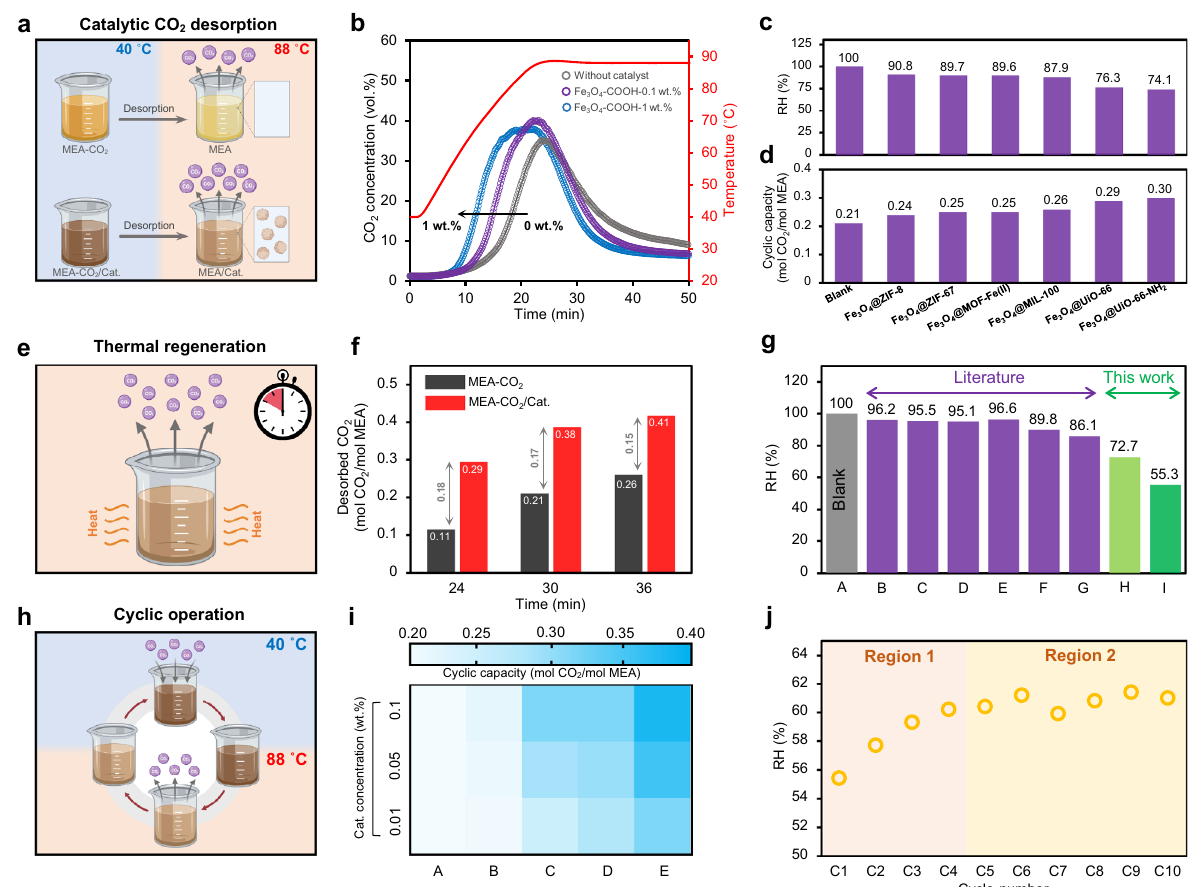
Fig. 5 Application of water-dispersible nanocatalysts for energy-ef fi cient CO 2 capture. a Schematic of amine solvent regeneration with and without using a catalyst (Cat.). b CO 2 desorption pro fi le of amine solution with different concentrations of Fe 3 O 4 – COOH. c Relative heat duty (RH) and d cyclic CO 2 uptake capacity of amine solution in the presence of various water-dispersible core – shell nanomaterials. e Schematic of catalytic CO 2 desorption during thermal solvent regeneration. f The effect of time on the accumulative desorbed CO 2 with and without using Fe 3 O 4 @UiO-66 – SO 4 . g RH of amine solution without ( a ) and with heterogeneous catalysts (Al 2 O 3 ( b ), V 2 O 5 ( c ), H-Beta ( d ), HZSM-5 ( e ), SO 4 2 − /ZrO 2 /Al 2 O 3 ( f ), SO 4 2 − /ZrO 2 /SBA-15 ( g )), water-dispersible Fe 3 O 4 – COOH ( h ), and Fe 3 O 4 @UiO-66-SO 4 ( I ). h Schematic of cyclic CO 2 absorption – desorption of catalyst-aided solvent regeneration. i The effect of catalyst concentration on the cyclic CO 2 capacity; blank ( a ), with H-Bata ( b ), Fe 3 O 4 – COOH ( c ), Fe 3 O 4 @UiO-66 ( d ), and Fe 3 O 4 @UiO-66- SO 4 ( e ). j Recyclability of the Fe 3 O 4 @UiO-66 – SO 4 during consecutive CO 2 absorption – desorption cycles. The amine solution in all cases is 5 M MEA in water and no catalyst was used for the blank solvent. The concentration of catalyst was fi xed at 0.1 wt% in ( c , d , f , g , j nanoparticles ( ⁓ 5.3 – 8.8), which could be deprotonated at low pH values and prevent the subsequent disassembly of Fe – O structure.